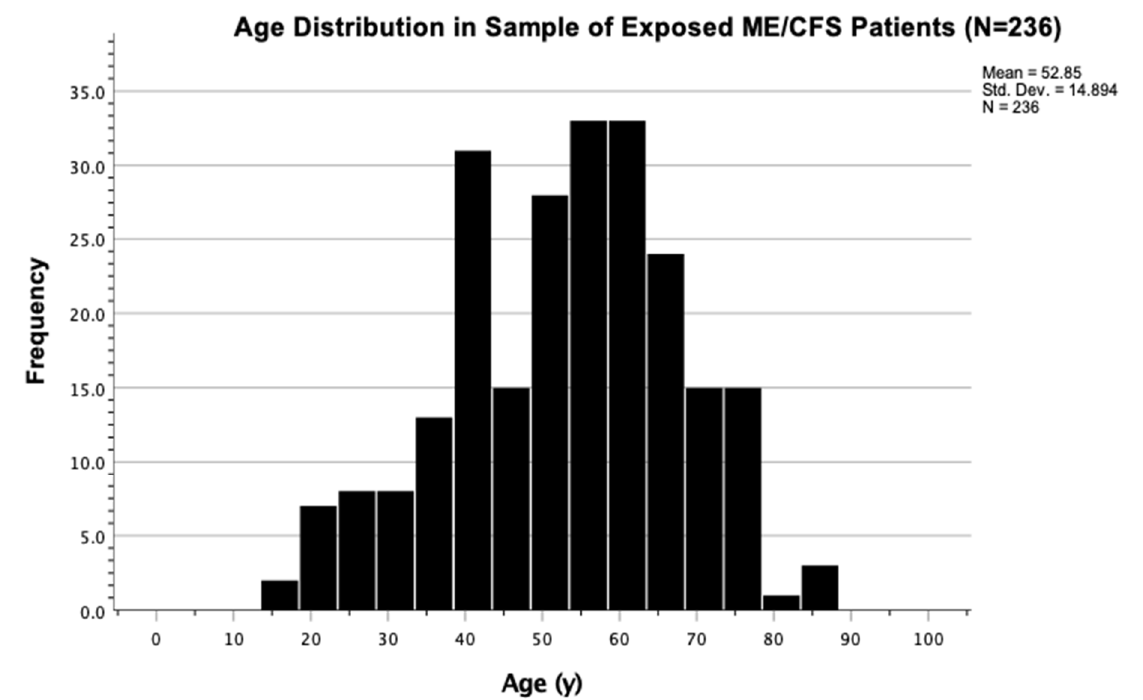
Figure 7. The mean age at diagnosis in ME/CFS patients who reported a history of chronic mold exposure was determined to be close to 53 years old. Bimodal peak incidence of age was noted at 40 years and 55–65 years of age.